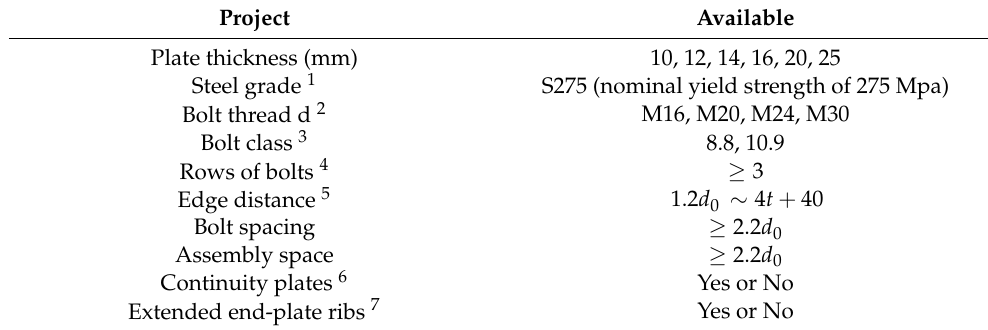
Table 2. Variables of a